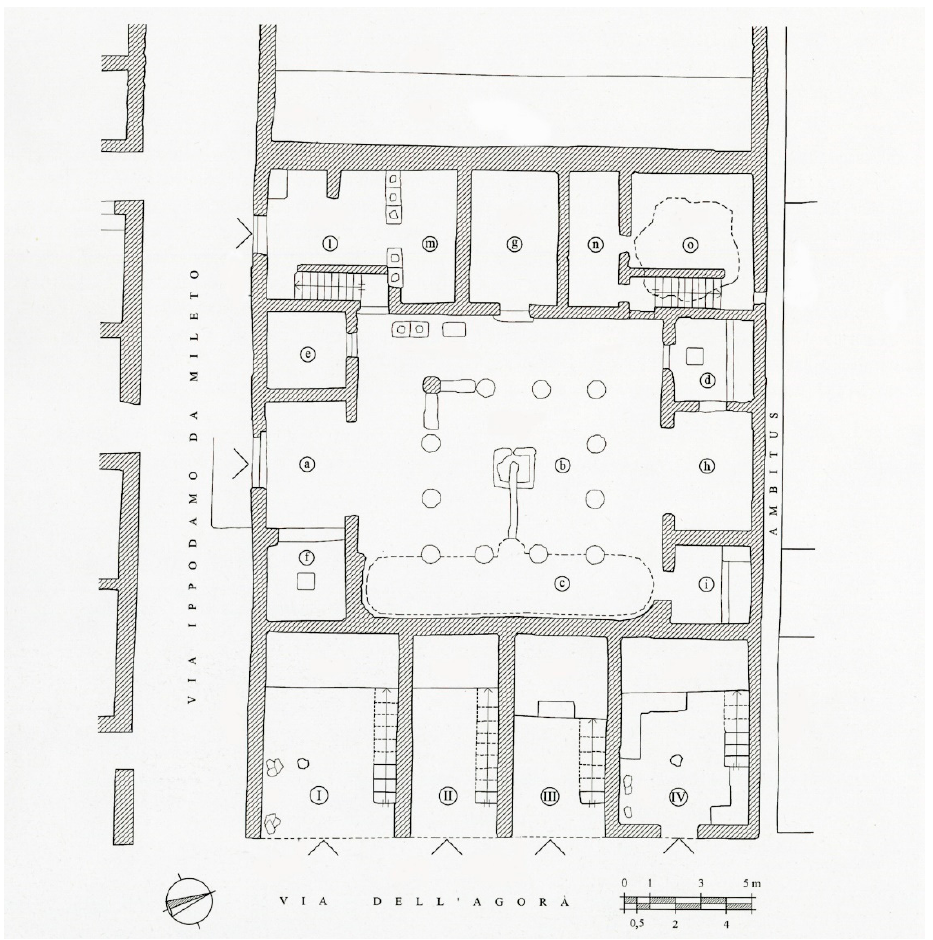
Figure 1. Plan of the House of Leda at Soluntum (after Sposito 2014, p. 164, Figure 2).